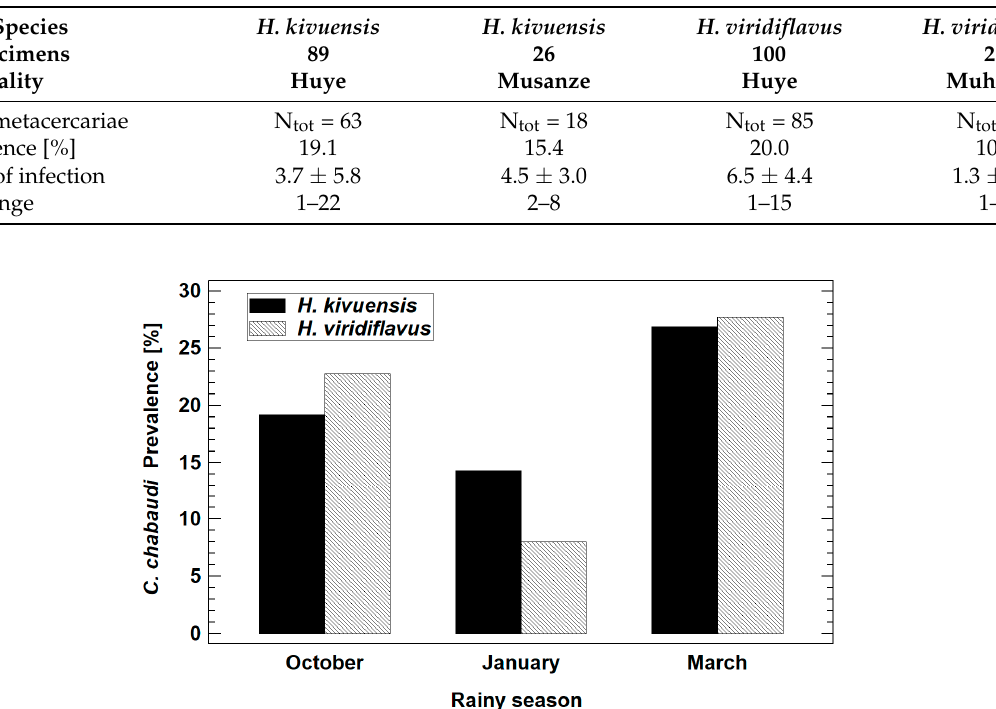
Figure 5. Seasonal variation of metacercaria prevalence in the reed frogs at Huye. Table 4. Clinostomum chabaudi metacercariae infesting lymphatic sacs, mouth, and body cavity of Hyperolius reed frogs in Rwanda: number of metacercariae (N tot ), prevalence (presented as the number of parasitized frog hosts by the total number examined), mean intensity of infection ± SD (as mean number of parasites per individual frog), and range of metacercariae recorded.